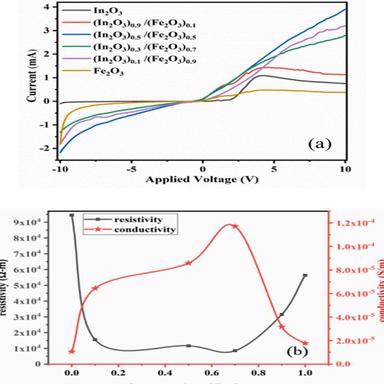
(a) Current (I) voltage (V) curve of (In2O3)x/(Fe2O3)1-x (x = 1, 0.9, 0.5, 0.3, 0.1, 0) (b) resistivity (Ω-m) and conductivity (S/m) of (In2O3)x/(Fe2O3)1-x (x = 1, 0.9, 0.5, 0.3, 0.1, 0).